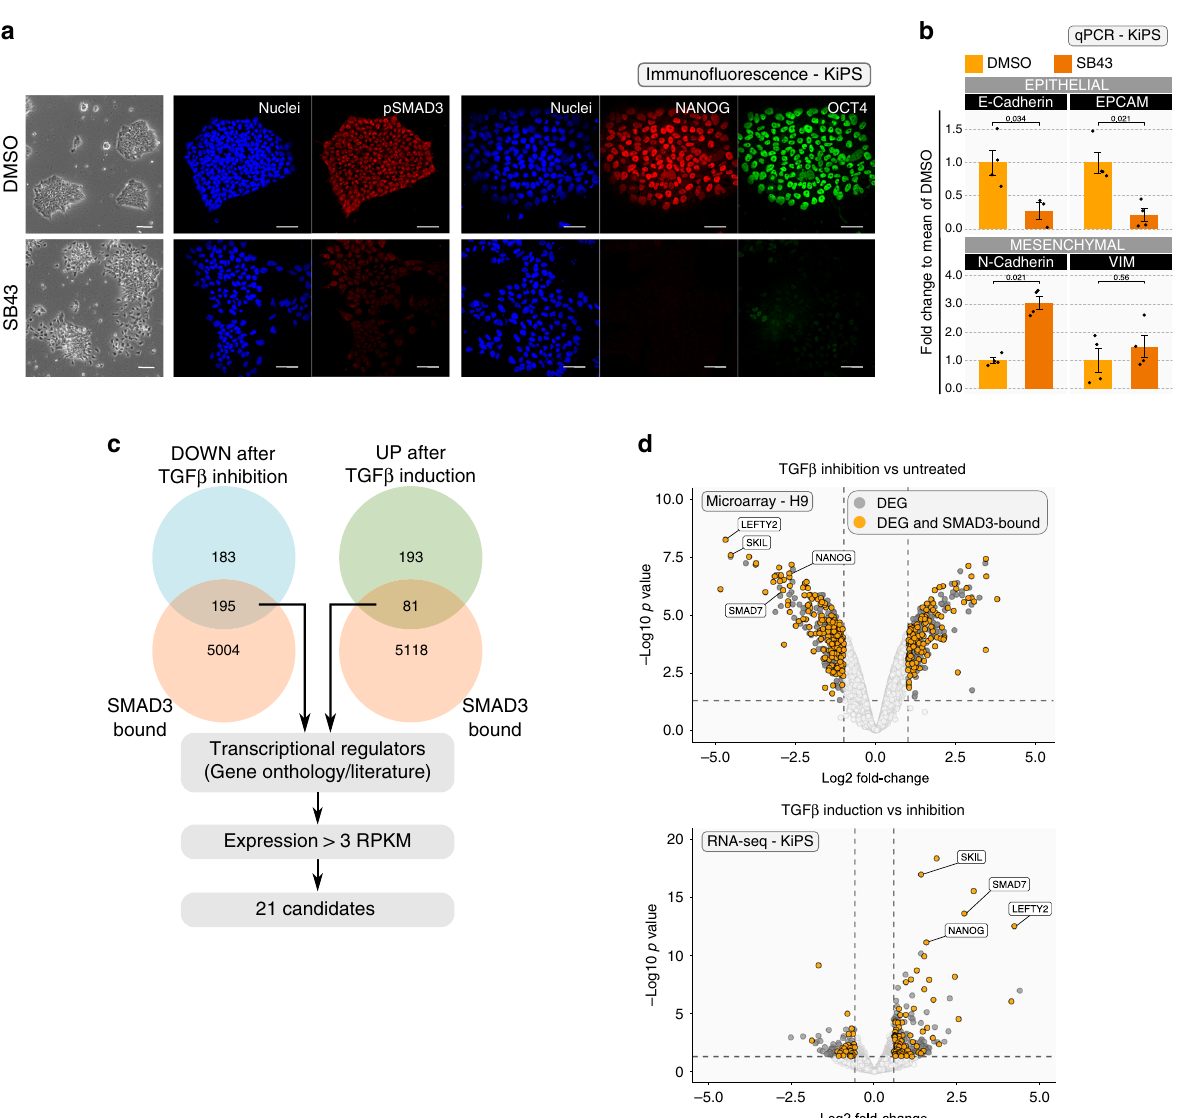
Fig. 1 Identi fi cation of TGF-beta/SMAD3 transcriptional targets in hPSCs. a Left: Morphology of KiPS treated with SB43 (10 µ M) or the vehicle DMSO for 5 days. Right: Immunostaining for phosphorylated SMAD3 (pSMAD3) and the pluripotency markers NANOG and POU5F1/OCT4 shows a reduction